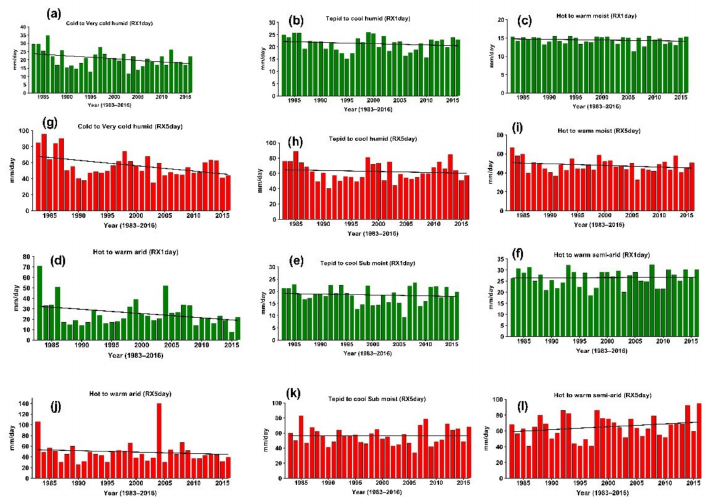
Figure 11. Maximum precipitations of 1 day (Rx1DAY) ( a – f ) and 5 days (Rx5DAY) ( g – l ) over agroeco- logical zones for the period 1983–2016.